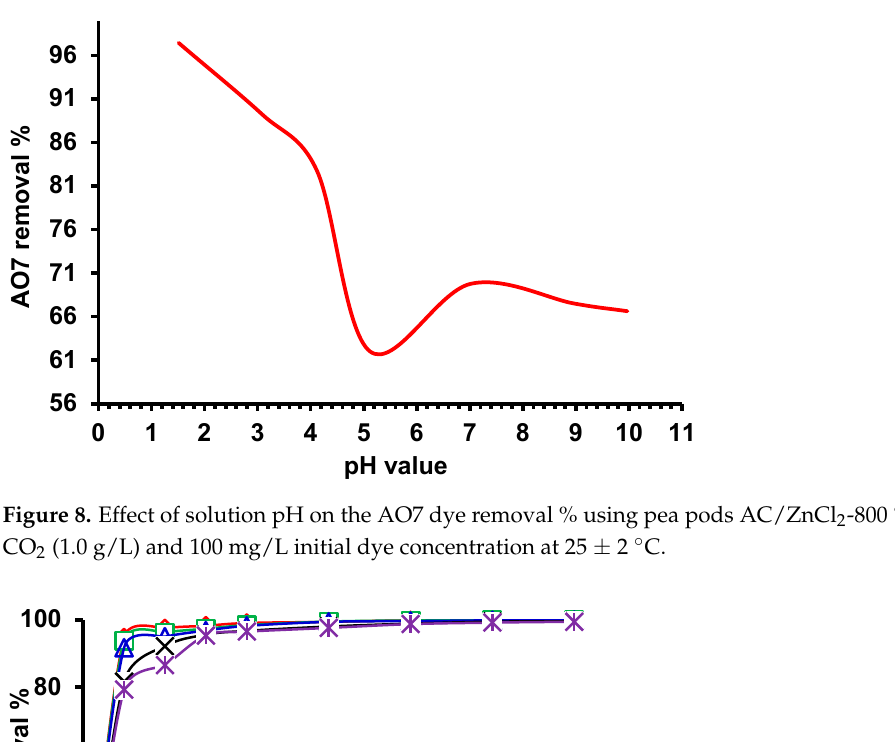
Figure 7. BJH analysis of AC prepared from pea pods impregnated using (a) KOH and carbonized under N 2 gas flow, (b) KOH and carbonized under CO 2 gas flow, (c) ZnCl 2 and carbonized under N 2 gas flow, and (d) ZnCl 2 and carbonized under CO 2 gas flow.